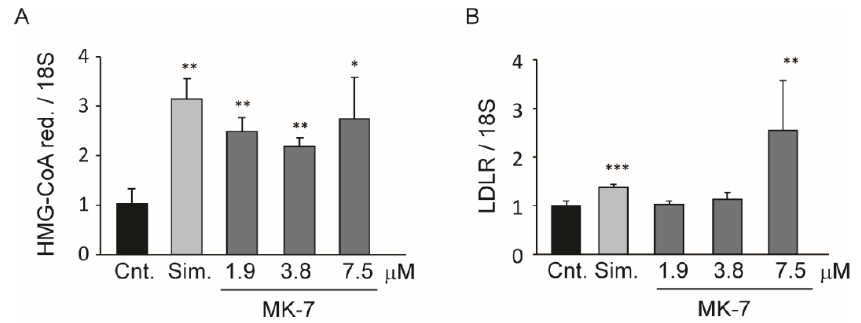
Figure 3. Effect of MK-7 on HMG-CoA reductase and LDLR mRNA expression. Cells were seeded in MEM/10% FCS and incubated the day after with MEM/10% FCS in the presence or absence of simvastatin (40 µM) or indicated concentrations of MK-7. After 24 h, total RNA was prepared and mRNA levels of HMG-CoA reductase ( A ) and LDLR ( B ) were determined by quantitative real-time PCR. Differences between treatments were assessed by Student’s t test. * p < 0.05 vs. control; ** p < 0.01 vs. control; *** p < 0.001 vs. control. Sim.: simvastatin.